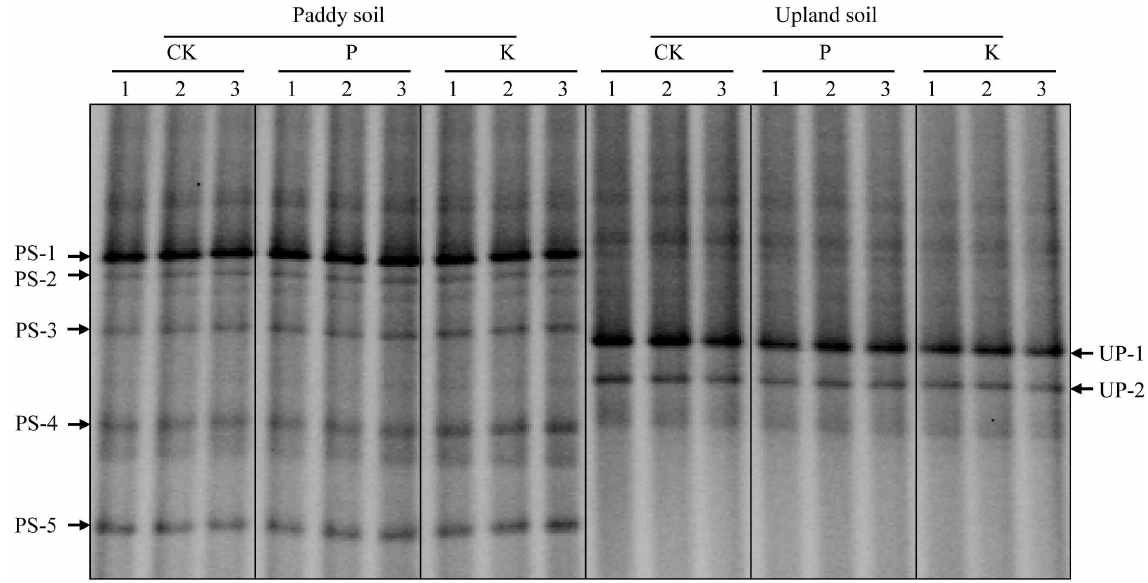
Fig. 2. DGGE fingerprints of archaeal amoA genes derived from CK, P and K treatments of upland and paddy soils. The arrows indicate DGGE bands excised for sequencing. Lanes 1, 2 and 3 represent three replicated plots for each